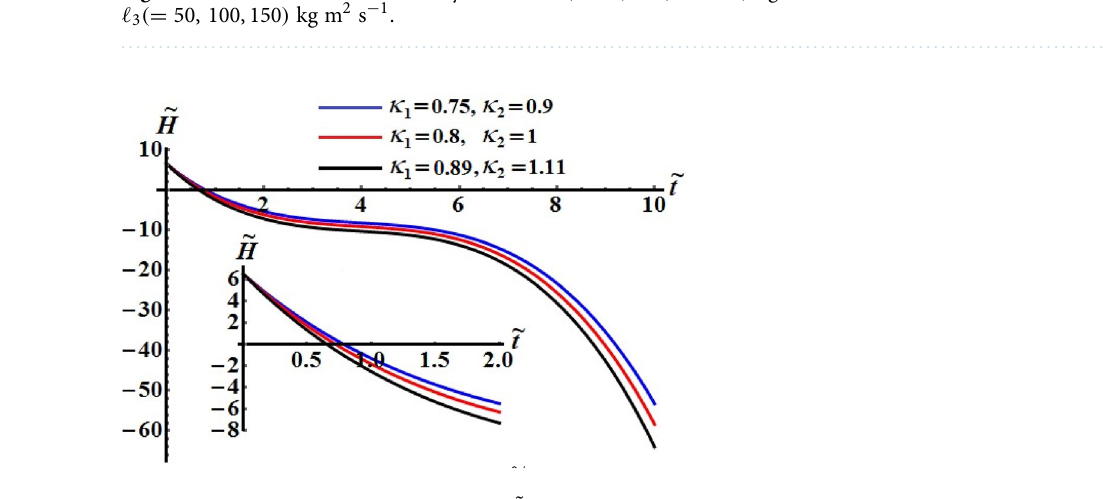
Figure 14. Depicts the temporal history of ˜ H at σ = 1.3